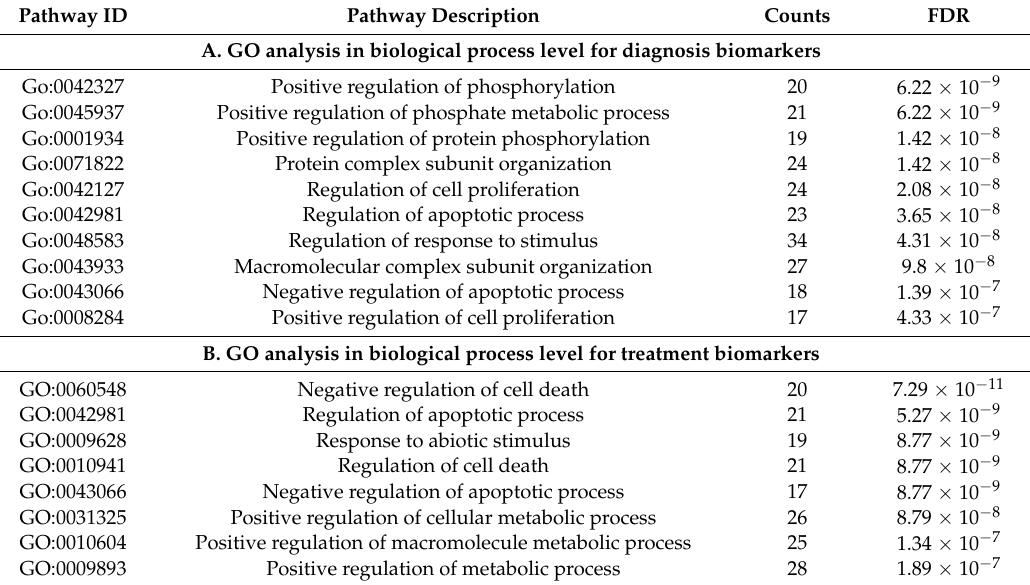
Table 2. GO analysis results in biological process level for CRC protein